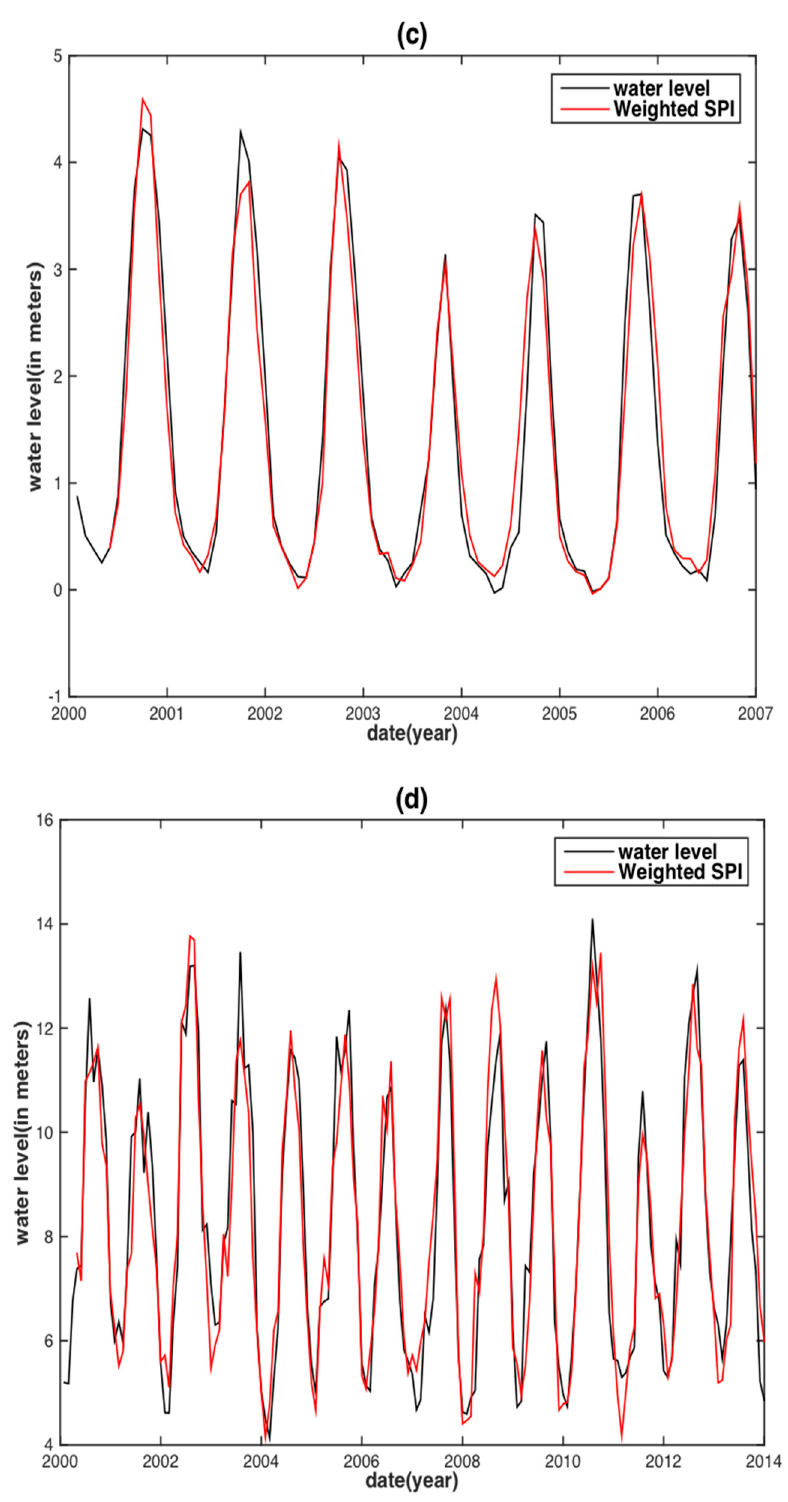
Figure 9. Water level reconstruction based on weight-averaged TRMM precipitation against the observed water level in the MRB ( a ) and the YRB ( b ) and weight-averaged TRMM-SPI reconstructed water level against the observed water level in the MRB ( c ) and the YRB ( d ).